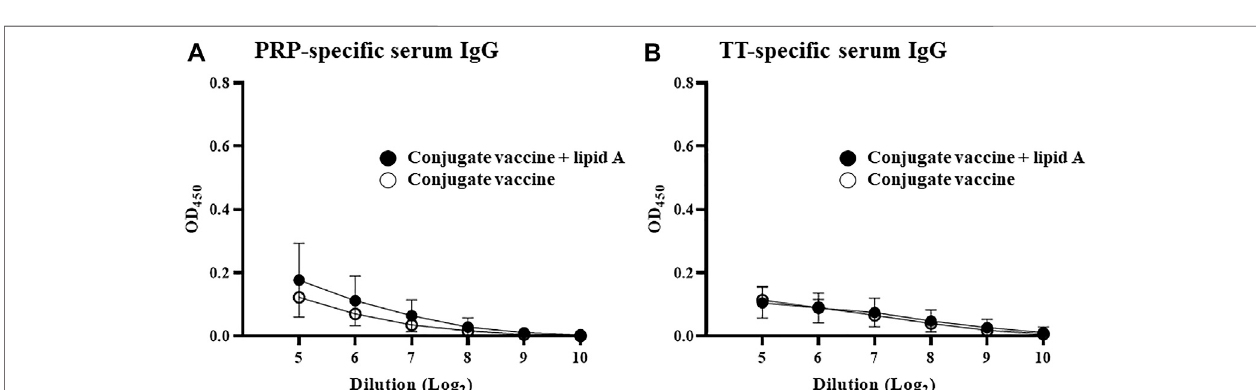
FIGURE 3 | T cells are required for Alcaligenes lipid A – promoted PRP-speci fi c IgG production. T cell – de fi cient nude mice were immunized subcutaneously with Haemophilus Bconjugate vaccine withor without 1 μ gofAlcaligeneslipid A.Serum wascollected 1 week after the fi nalimmunization, and thelevels of (A) PRP-speci fi c IgG and (B) TT-speci fi c IgG were measured by ELISA. Data are representative of two independent experiments and are presented as mean ± 1 SD (n (cid:2) 4/group).